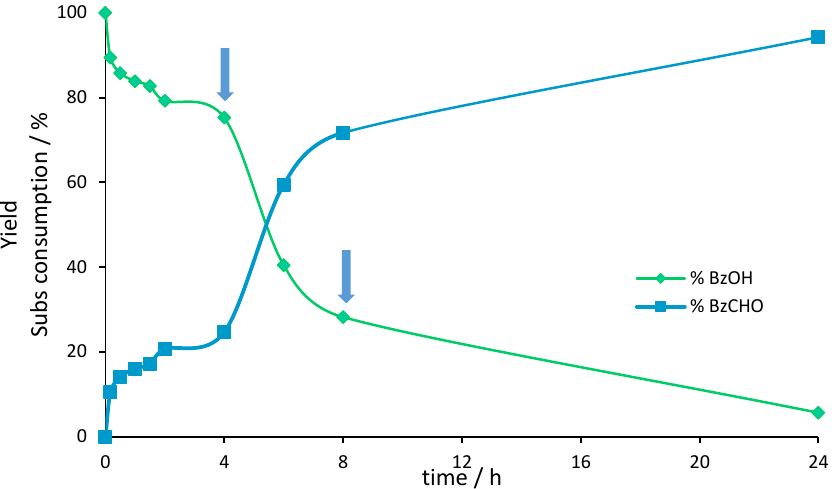
Figure 7. Catalytic oxidation of BnOH with MoO 2 –Fe 2 O 3 and H 2 O 2 , with two extra additions of H 2 O 2 at 4 h and 8 h. Arrows denote the new additions of H 2 O 2 .